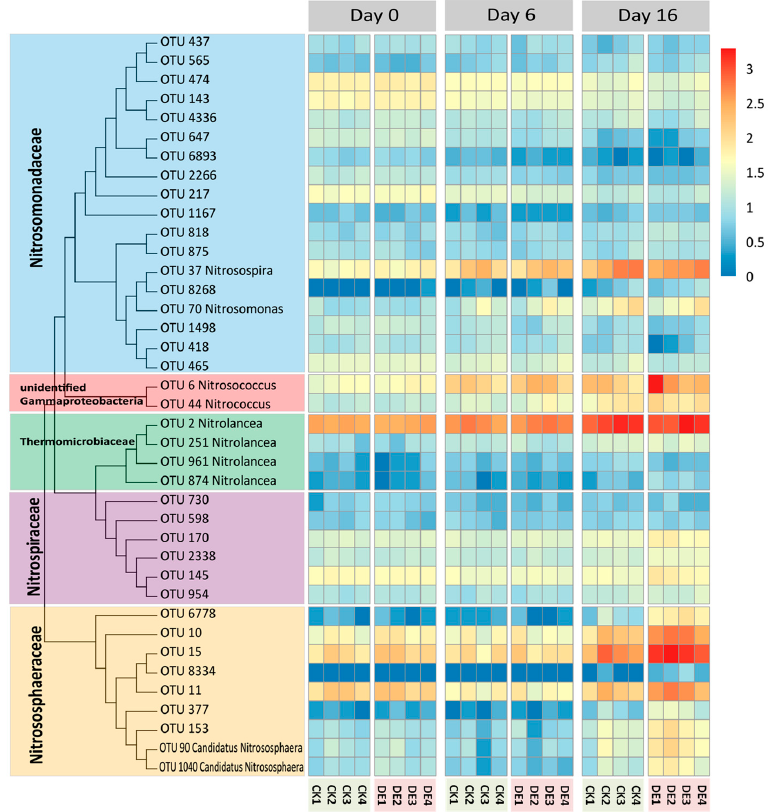
Figure 4. Relative changes in the nitrifying microbial abundance during soil incubation. Note: CK, ordinary water, and DE, ionized water. Numbers in the treatment labels: 1, 30% θ FC ; 2, 60% θ FC ; 3, 100% θ FC and 4, 175% θ FC .